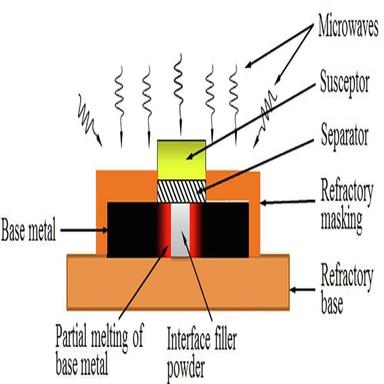
Schematic diagram of joining metallic plates through microwave hybrid heating.